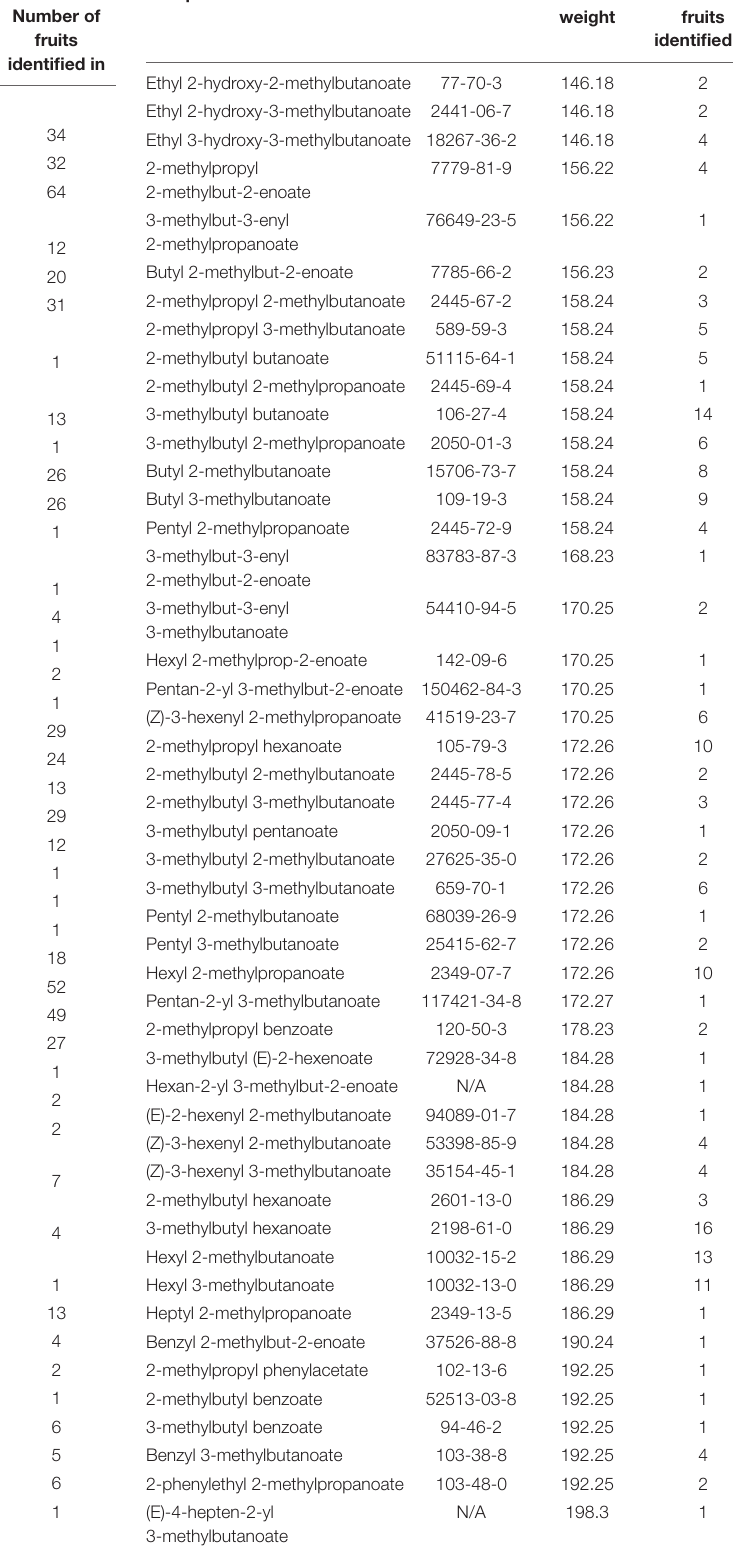
TABLE 1 | List of all branched-chain volatile compounds detected in 106 edible fruits across 175 published studies of fruit volatile